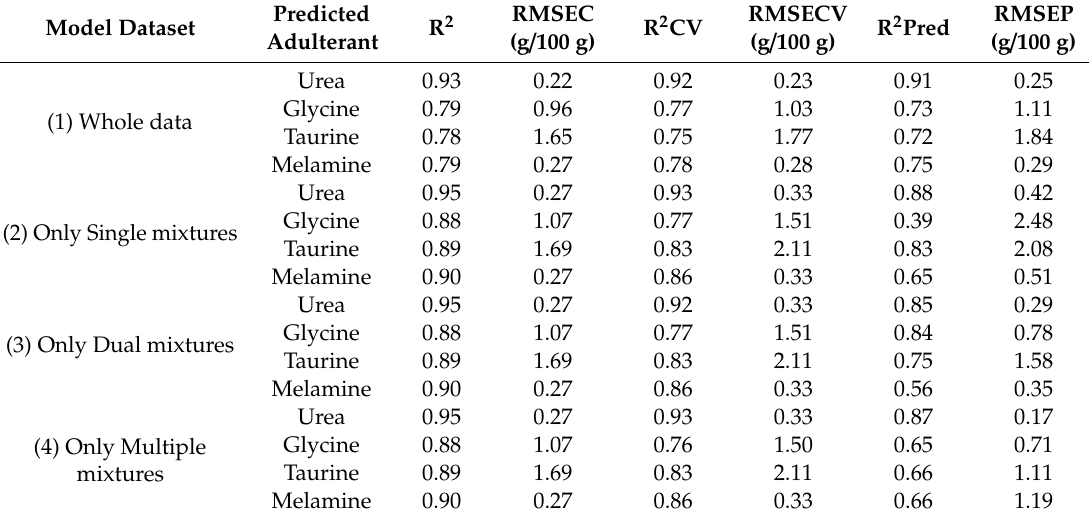
Table 2. PLSR models for adulterated whey protein powder samples scanned with the handheld spectrometer through the commercial LDPE plastic bag and analyzed at the spectral range of 950–1650